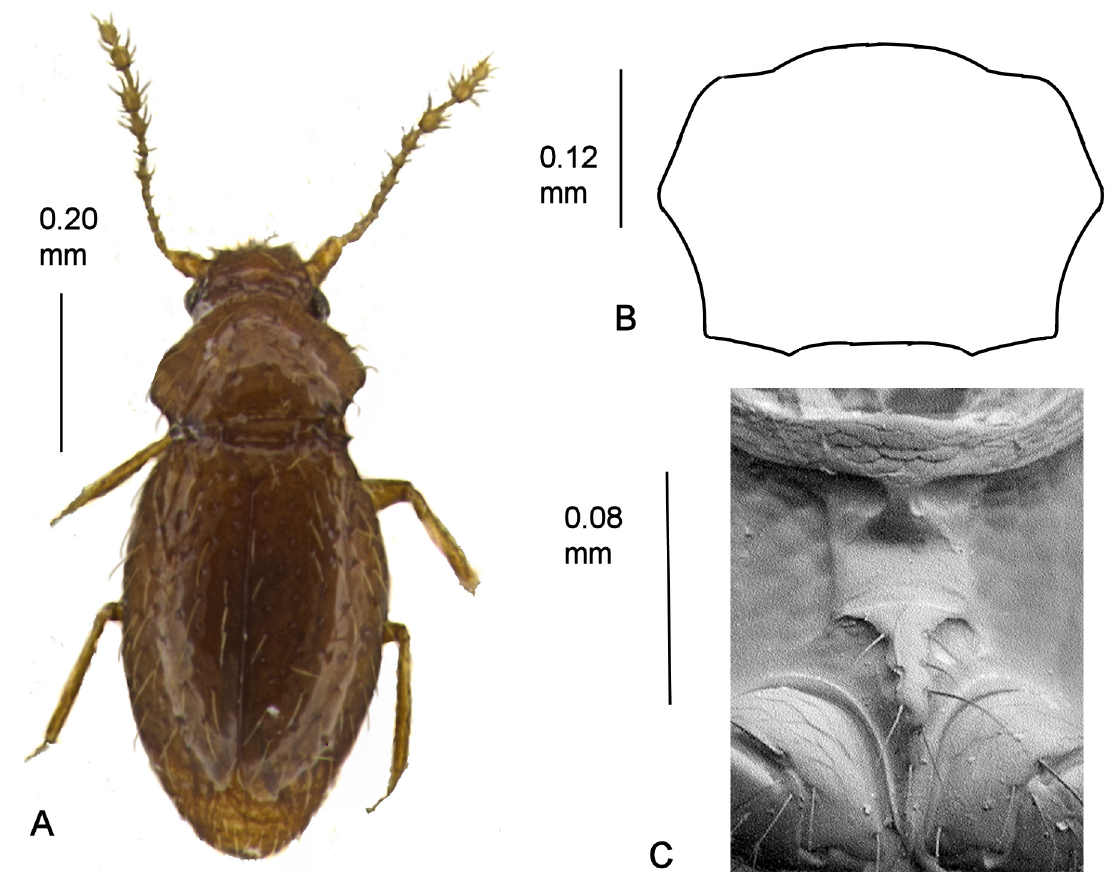
Fig. 102 . Cissidium sawadai Darby, 2015. A . Habitus. B . Pronotum, C . Mesoventrite showing median process of collar, mid-keel and keel, ×